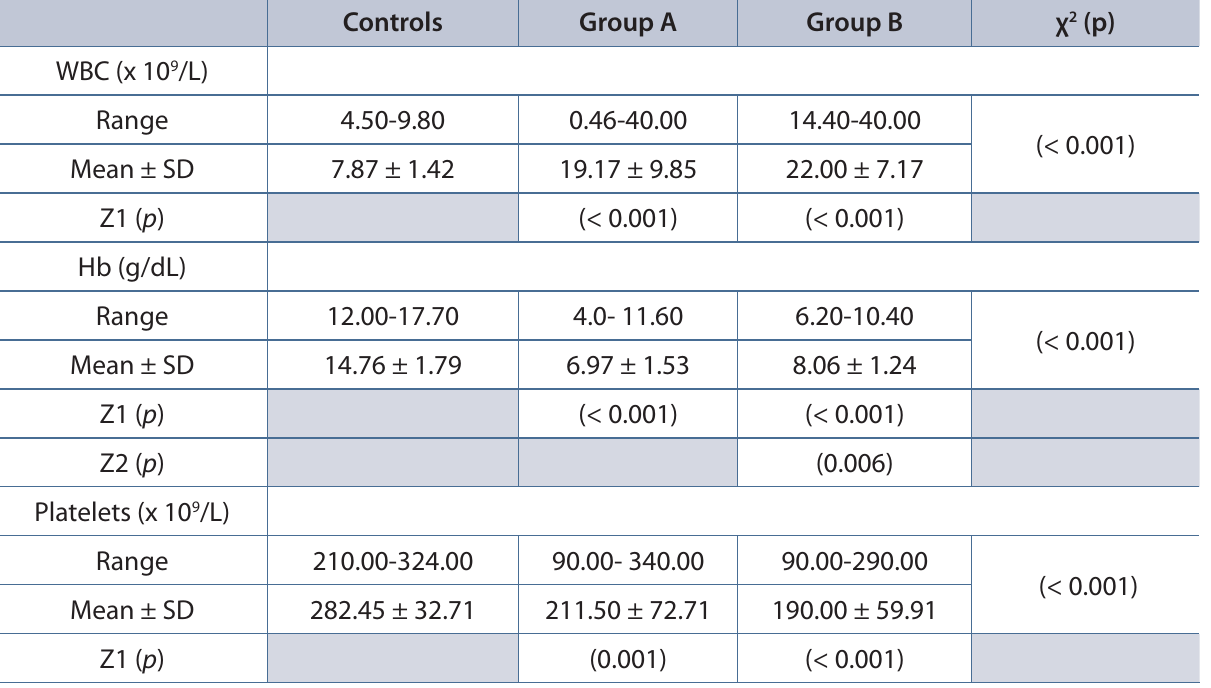
Table 1. Comparison of WBC count, hemoglobin values (Hb) and platelet count among the studied groups